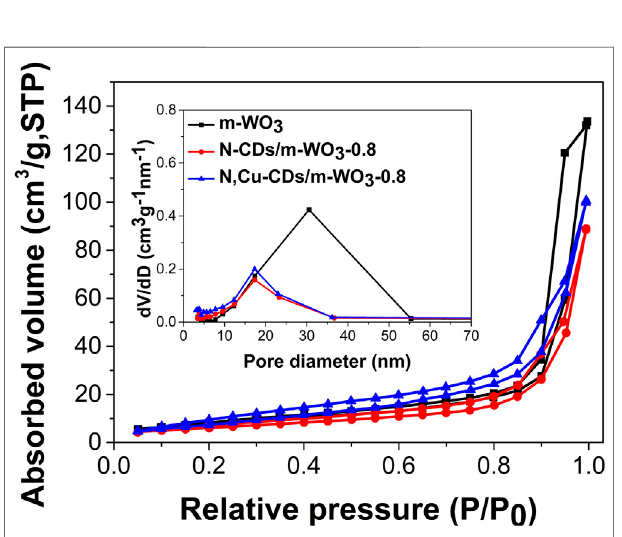
FIGURE1| SEMandTEMimagesofas-synthesizedsamples.SEMimageofN,Cu-CDs/m-WO 3 (A) ;TEMimagesofN,Cu-CDs/m-WO 3 (B) and (C) ;TEMimageof N,Cu-CDs (D) ; and FETEM images of N,Cu-CDs/m-WO 3 (E – F) .